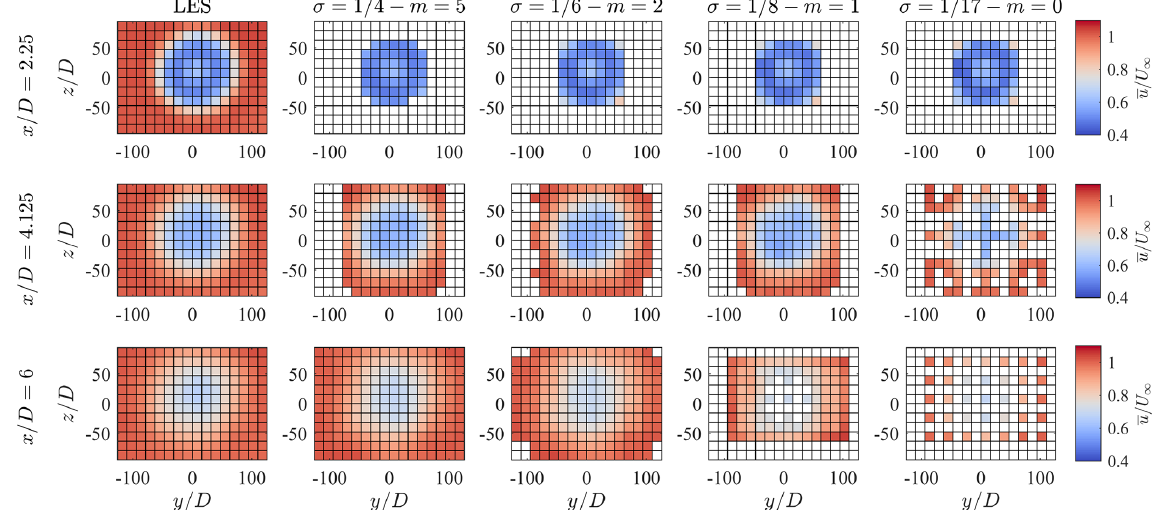
Figure 16. Mean streamwise velocity fields obtained through the ideal lidar simulator with (cid:49)θ = 2 . 5 ◦ over cross-flow planes at three downstream locations and four combinations of σ − m , compared with the corresponding LES